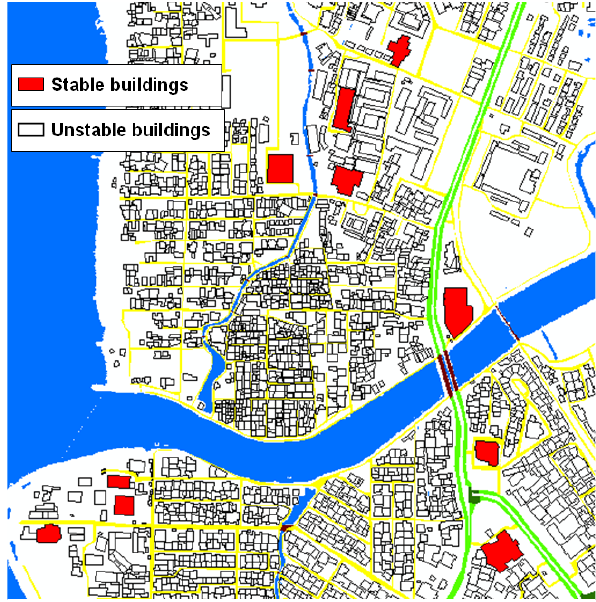
Fig. 7. Identification of scenario dependent stable structures combining the capabilities of civil engineering and remote sensing